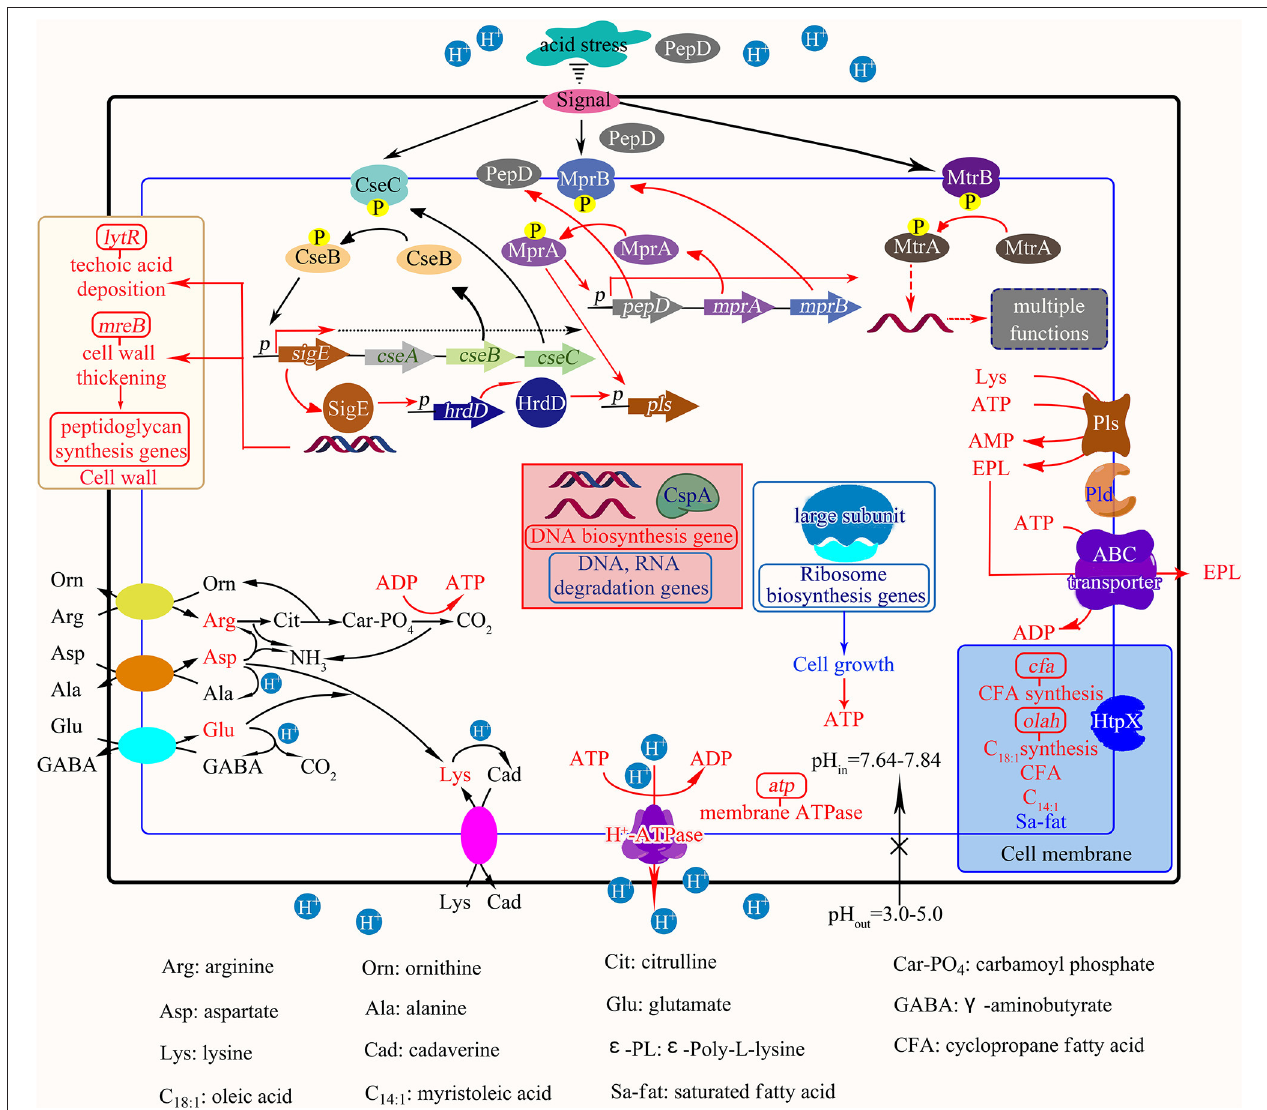
FIGURE 2 | The physiological and transcriptional response mechanisms of S. albulus to spontaneous acid stress in the commercial biosynthesis of EPL (Wang C. Y. et al.,